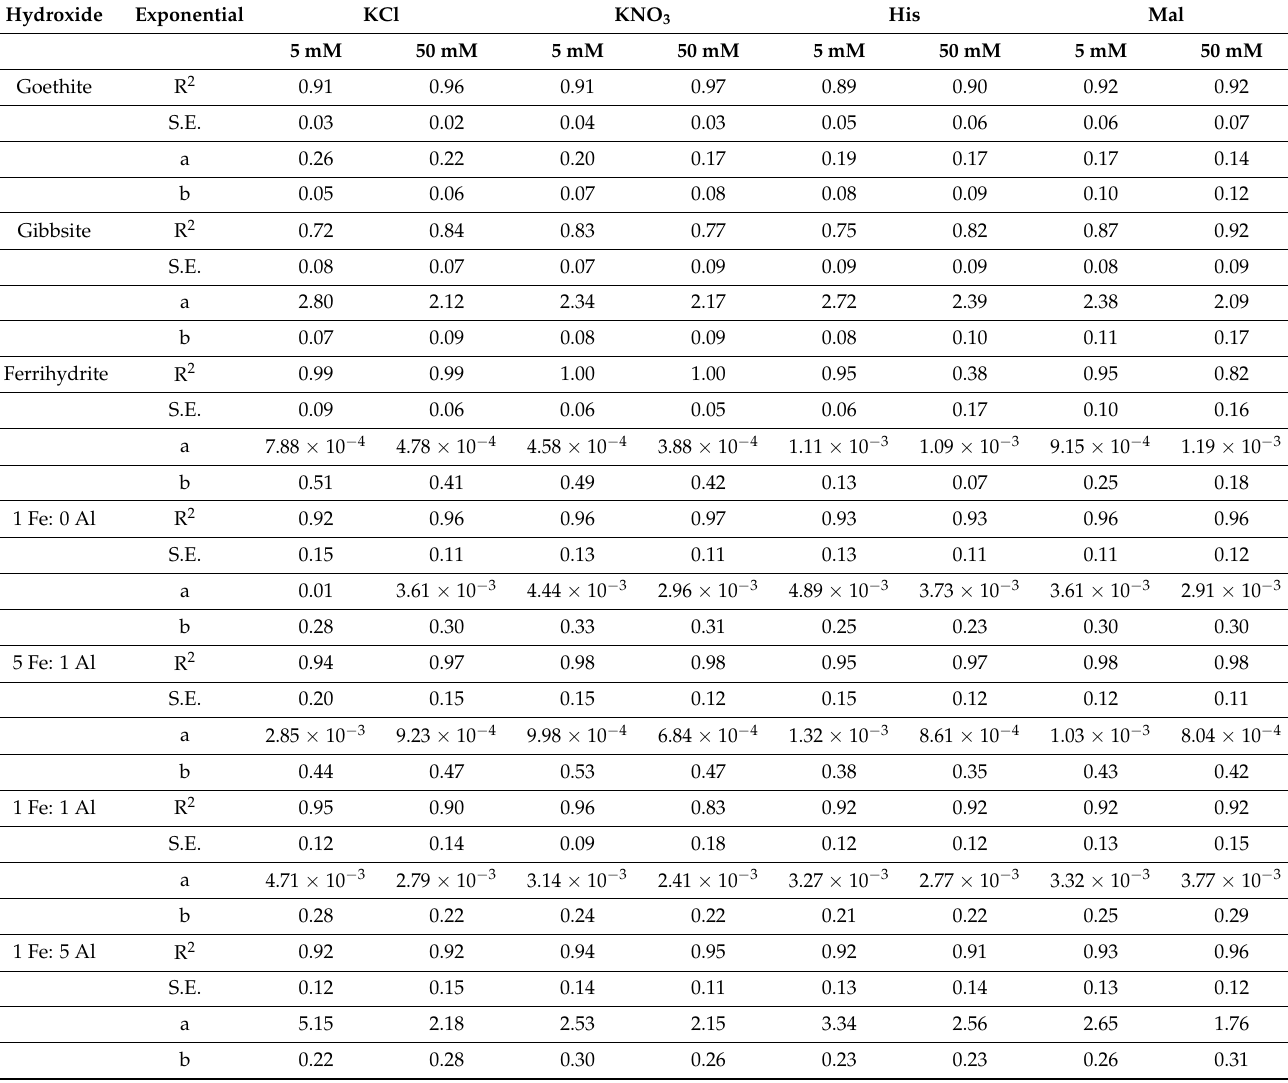
Table 5. Coefficients of determination (R 2 ), standard error (S.E.), and calculated kinetic parameters for the exponential function used to describe the kinetic release of P after 336 h desorption